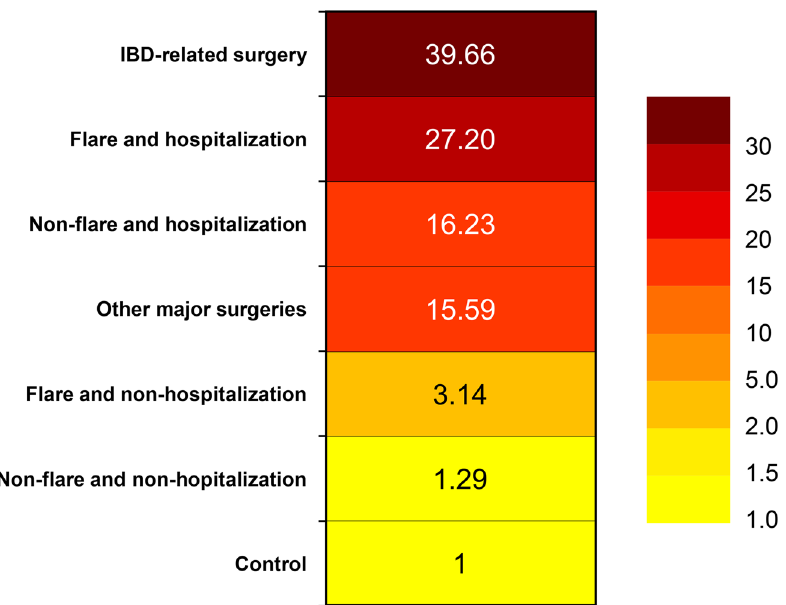
Figure 2. Heat map of risk of venous thromboembolism by different phases of IBD patients. Adjustment for age, sex, provoking factors (recent surgery, fracture, and pregnancy within 90 days of event), and